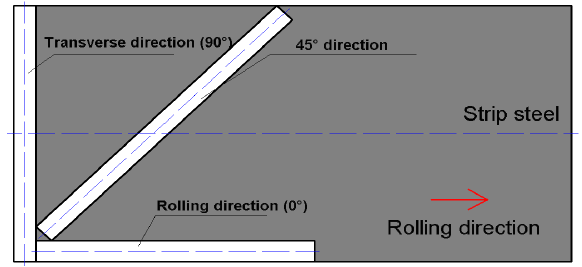
Figure 9. Analysis of influence factor for stress detection signal.